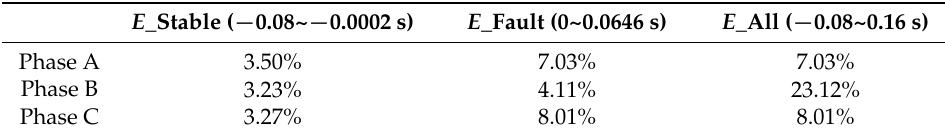
Table 3. Accuracy evaluation results of case II.